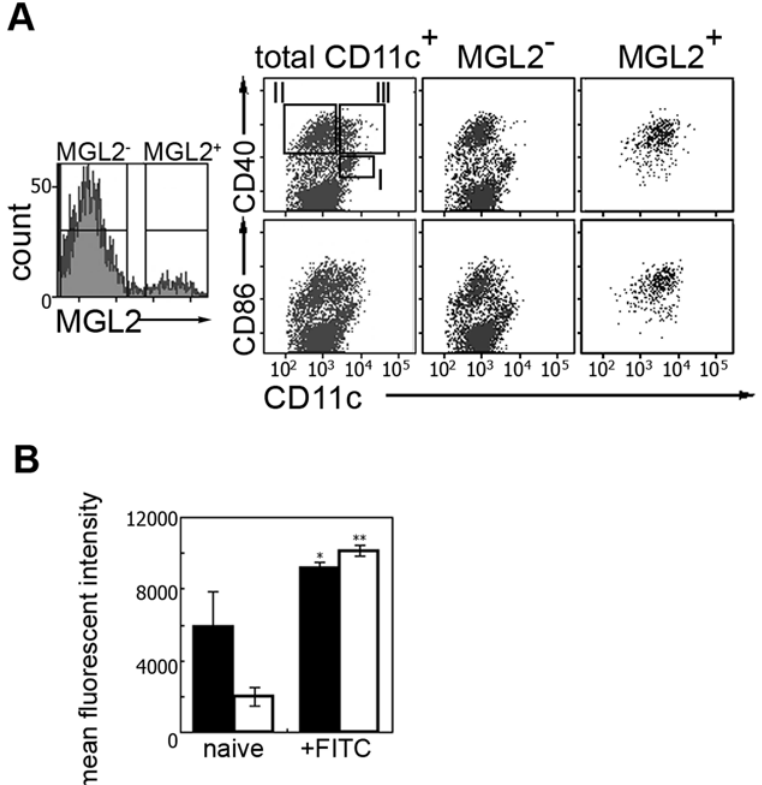
Figure 4. Expression of co-stimulatory molecules in MGL2 + DDC revealed by the flow cytometric analysis. (A) CD40 and CD86 staining on MGL2 + DDC in naive cutaneous LNs. MACS-purified CD11c + DCs were sub-divided into MGL2 + DDCs and MGL2 2 DCs (left panel). Populations I-III indicate known cDC subsets in murine LNs. Note that MGL2 + DDCs were exclusively assigned to population III (CD11c hi CD40 hi DC). (B) Mean fluorescent intensity of CD40 (filled bars) and CD86 (open bars) staining of MGL2 + DDCs after FITC sensitization in the LN. * p , 0.05, ** p , 0.00005. Mean 6 SD obtained from three mice is shown.